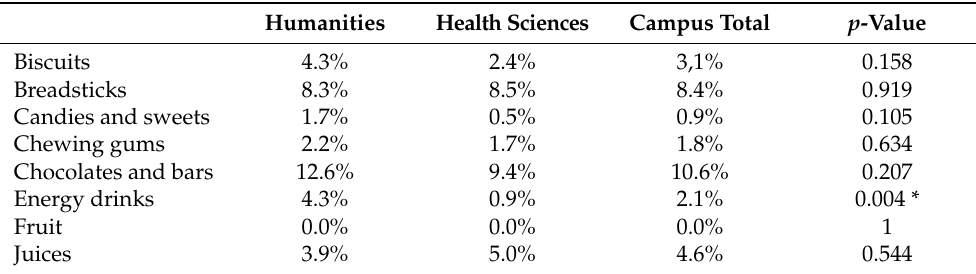
Figure 1. Percentage of foods with high, medium and low content of fats, saturated fat, sugars and salt expressed per 100 g of food product ( a ) and percentage of beverages with high, medium and low content of fats, saturated fat, sugars and salt expressed per 100 mL ( b ) in the whole campus. Classification according to the criteria in the Guide to creating a front-of-pack (FoP) nutritional label for pre-packed products sold through retail outlets. Table 2. Percentage of each product category (food and drinks) compared to the total number of products in each faculty and the Campus as a whole.